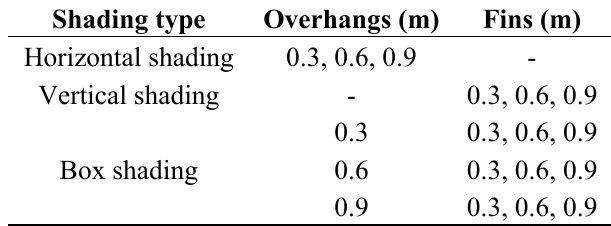
Table 6. Properties of the exterior shading used in this